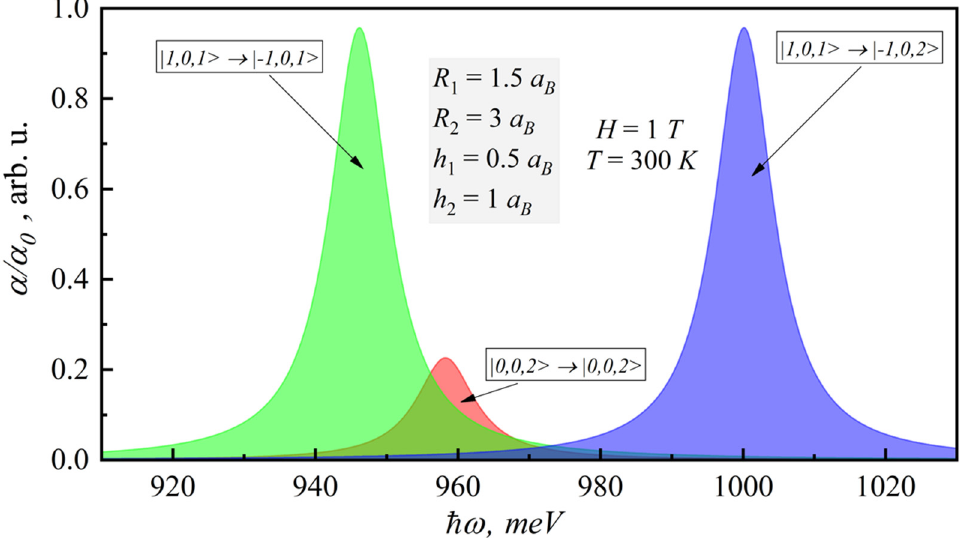
Figure 3. Dependence of the room-temperature interband absorption coefficient on photonenergy for different interband transitions.